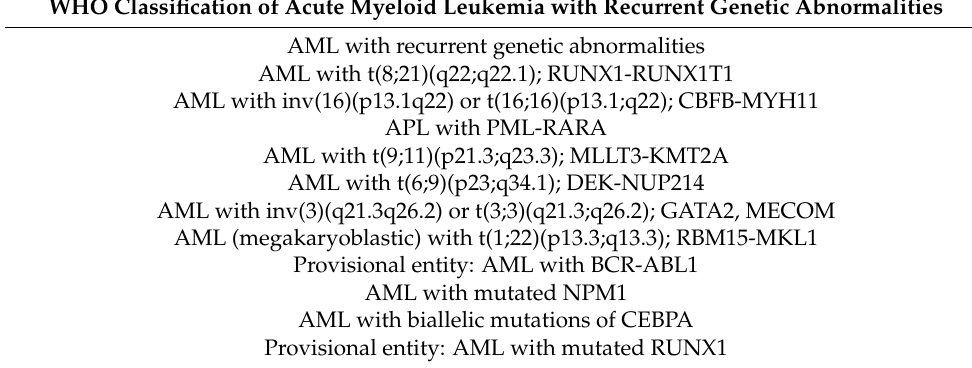
Table 1. Acute myeloid leukemia and acute leukemias of ambiguous lineage (WHO, 2017). WHO Classification of Acute Myeloid Leukemia with Recurrent Genetic Abnormalities AML with recurrent genetic abnormalities AML with t(8;21)(q22;q22.1); RUNX1-RUNX1T1 AML with inv(16)(p13.1q22) or t(16;16)(p13.1;q22); CBFB-MYH11 APL with PML-RARA AML with t(9;11)(p21.3;q23.3); MLLT3-KMT2A AML with t(6;9)(p23;q34.1); DEK-NUP214 AML with inv(3)(q21.3q26.2) or t(3;3)(q21.3;q26.2); GATA2, MECOM AML (megakaryoblastic) with t(1;22)(p13.3;q13.3); RBM15-MKL1 Provisional entity: AML with BCR-ABL1 AML with mutated NPM1 AML with biallelic mutations of CEBPA Provisional entity: AML with mutated